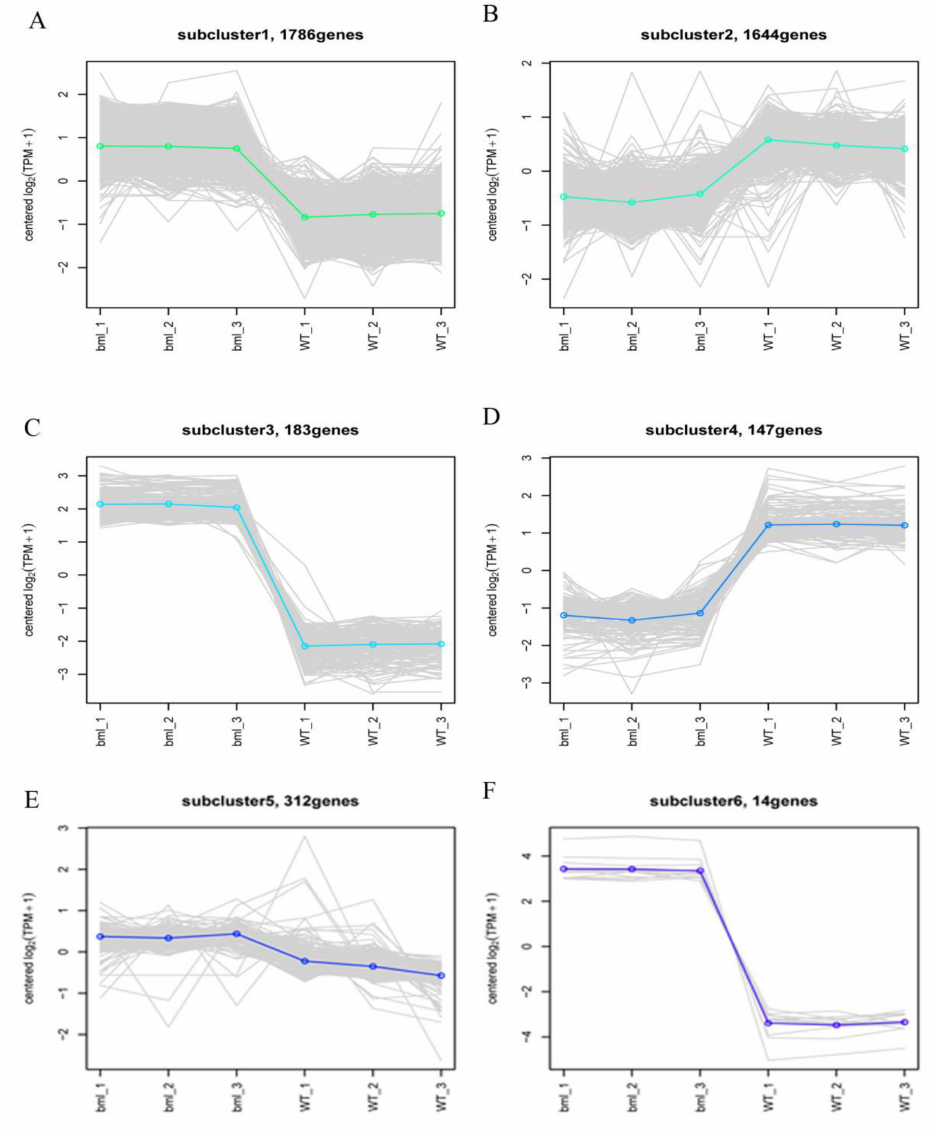
Figure 8. Differential gene module expression trends by the line chart. The expression trend line graph of each sub-module, the horizontal axis is the sample, and the vertical axis is the expression level of the gene in the sample. Each line in the figure represents a gene, and the colored lines represent the mean of a set of genes. Each graph shows one type of expression pattern, a trend that reflects changes in the expression levels of this group of genes; ( A,C,F ) up-regulated pattern of gene in the bml mutants but down-regulated in WT, ( B,D ) up-regulated pattern of gene in the WT but down-regulated in bml mutants and ( E ) genes had no response due to